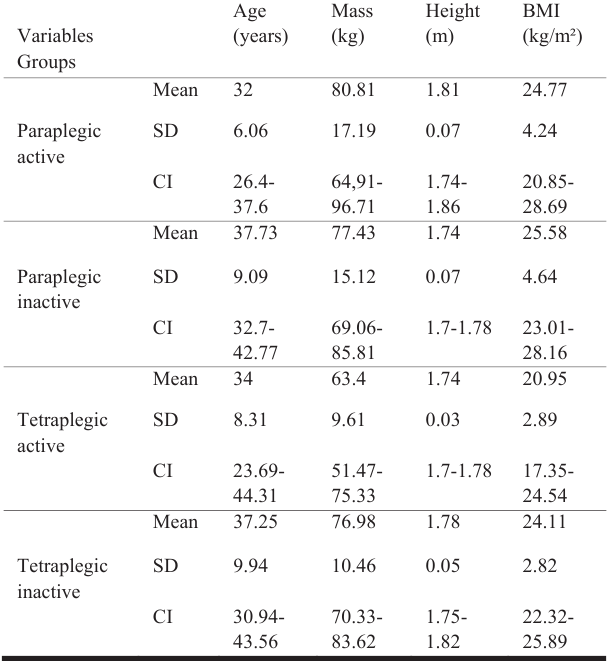
Table 1: Anthropometric data.